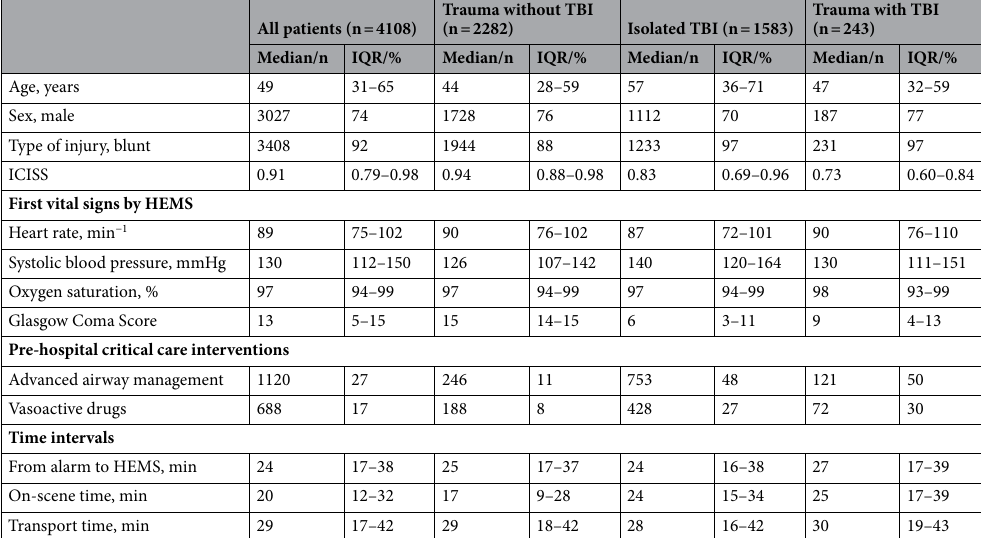
Table 1. Patient characteristics. TBI, Traumatic brain injury; IQR, interquartile range; ICISS, ICD-10 based Injury Severity Score; HEMS, Helicopter Emergency Medical Services. Pre-hospital critical care intervention means an intervention that has been performed during the prehospital period by the HEMS unit. Therefore, they have not affected the vital signs used for calculation of the shock index variants.